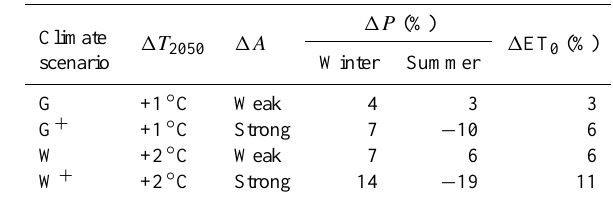
Table 2. Climate scenarios for the Netherlands for two possible de- velopments in global temperature change for 2050 ( 1T 2050 ) and two possible developments of the atmospheric circulation ( 1A ). The given changes are for the (climatic) mean precipitation ( 1P) and the Makkink reference crop evapotranspiration ( 1 ET 0 ) . For this study the scenario W + has been used.